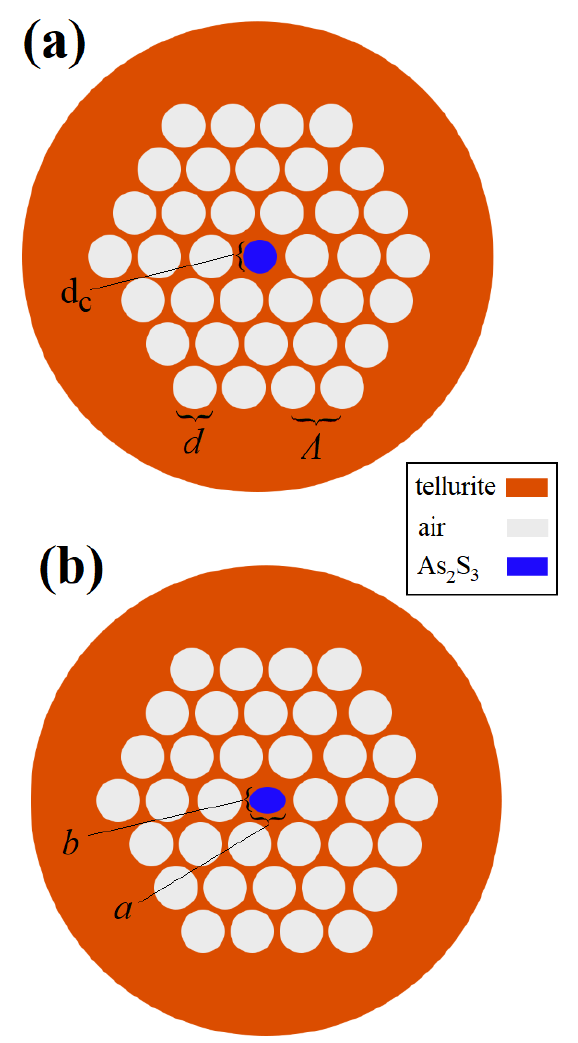
Figure 2. The cross-section of the proposed composite photonic crystal fiber (PCF) with tellurite in cladding, three rings of air-holes and As 2 S 3 in ( a ) a circular core and ( b ) an elliptical